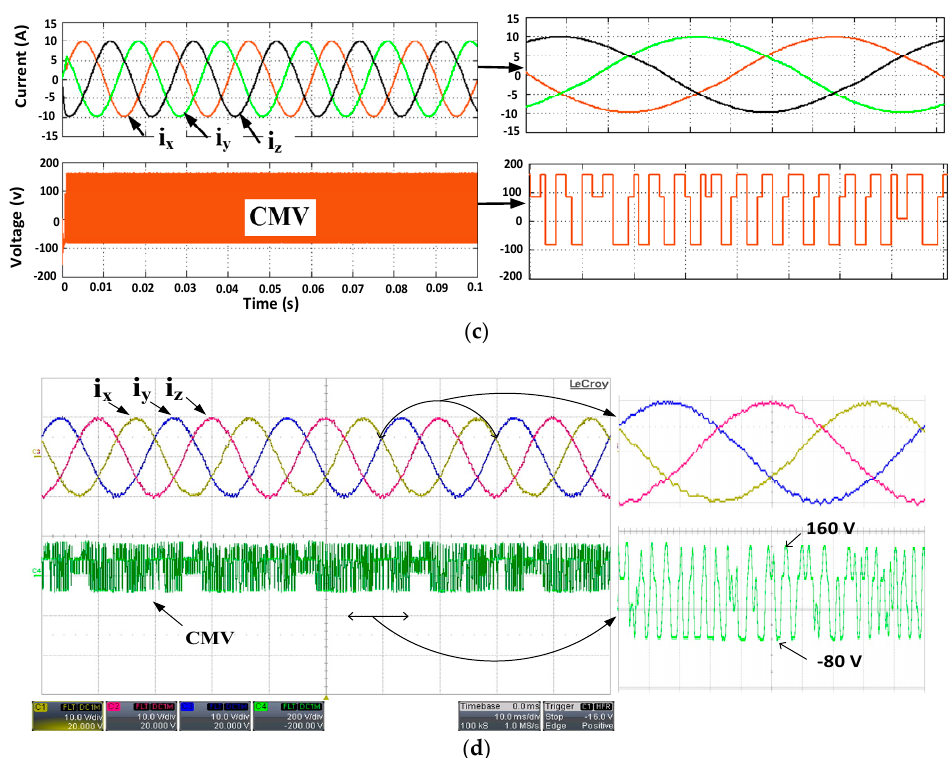
Figure 6. Each phase current and CMV for Case 2, first considering PPPP as the switching state: ( a ) Simulation result, ( b ) Experimental result; and considering NNNN as the switching state ( c ) Simulation result, ( d ) Experimental result ( I = 10 A/div., CMV = 200 V/div. and 10 ms/div.). In the third case, the proposed NSV-MPC was applied by using only six active vectors in each sampling instant to significantly reduce the peak-to-peak value of the CMV. Consequently, the calculation burden is also reduced through using a reduced number of switching vectors. Even though the ripple content in the load current is marginally higher than in Case 2, it is still in an , as shown in Figure 7. allowable range. The CMV is confined within ± (cid:3049) (cid:3279)(cid:3278) (cid:2872)